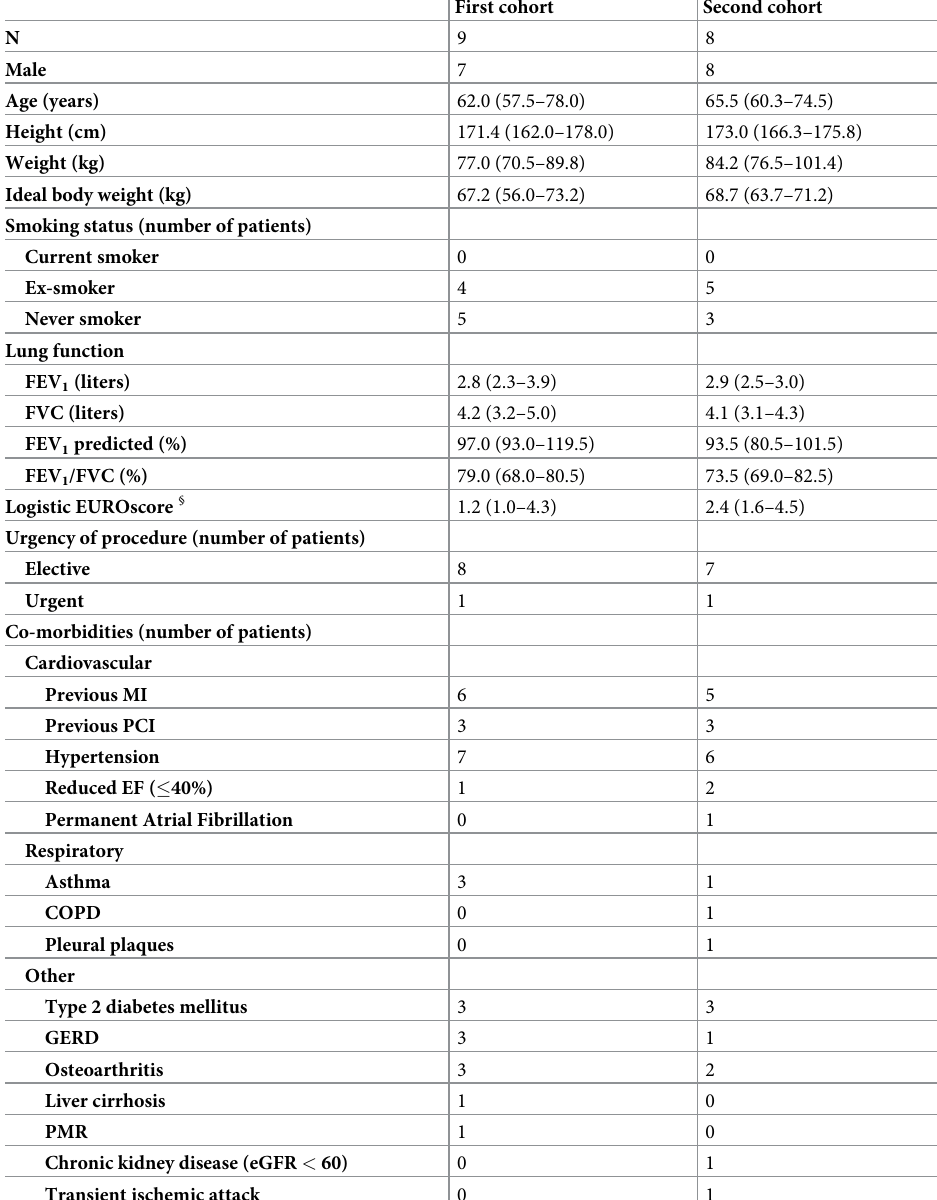
Table 2. Demographics and baseline clinical characteristics for the first and second